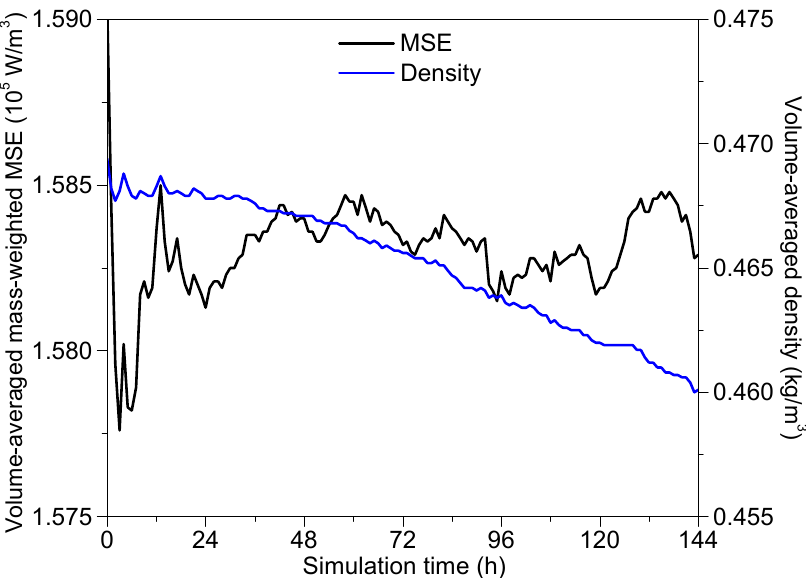
Figure 10. Time evolution of volume-averaged, mass-weighted MSE (10 5 W m − 3 ) and volume-averaged air density (kg m − 3 ).